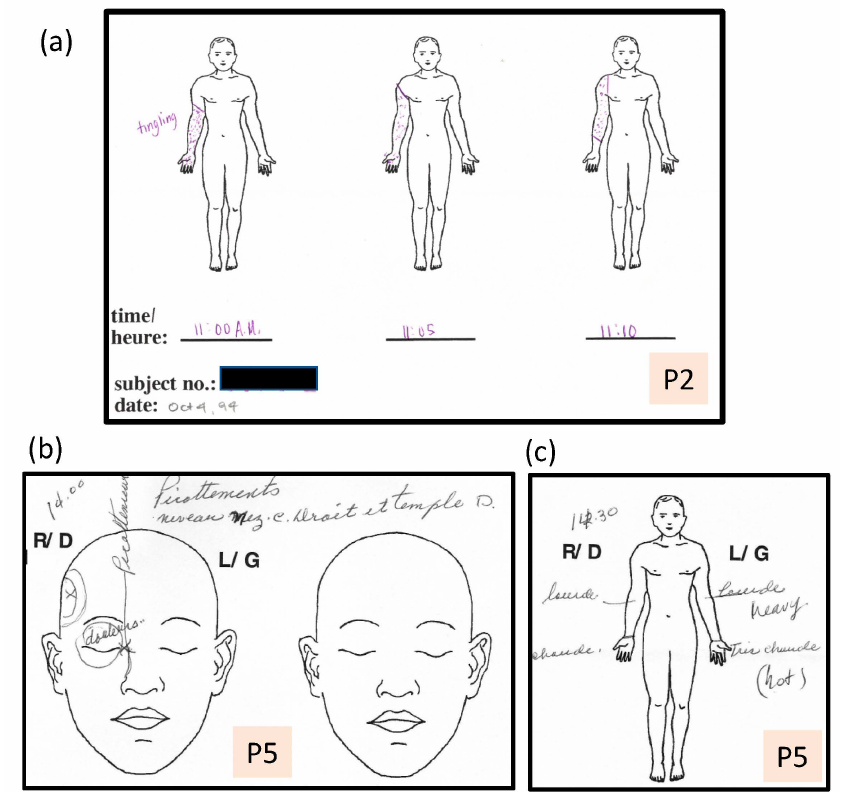
Figure 3. ( a ) P2: Unilateral aura affecting the arm and hand only, spreading to the shoulder over 10 min. ( b ) P5: An example of a somatosensory aura limited to tingling on the right side of her nose and at her right temple (“picottements niveau nez droit et temple d(roit)”), along with pain (“douleurs”) in the area of her right eye. ( c ) P5: 30 min later in the same episode, indicating heaviness (“lourd”) in both arms, and heat (“tr è s chaud”) in both hands. In summary, aura symptoms in different body regions were not sequential; rather symptoms in the face and upper limb seemed to begin together or within a short time of one another. Locally, spread in the arm seems consistent with local CSD. Pattern